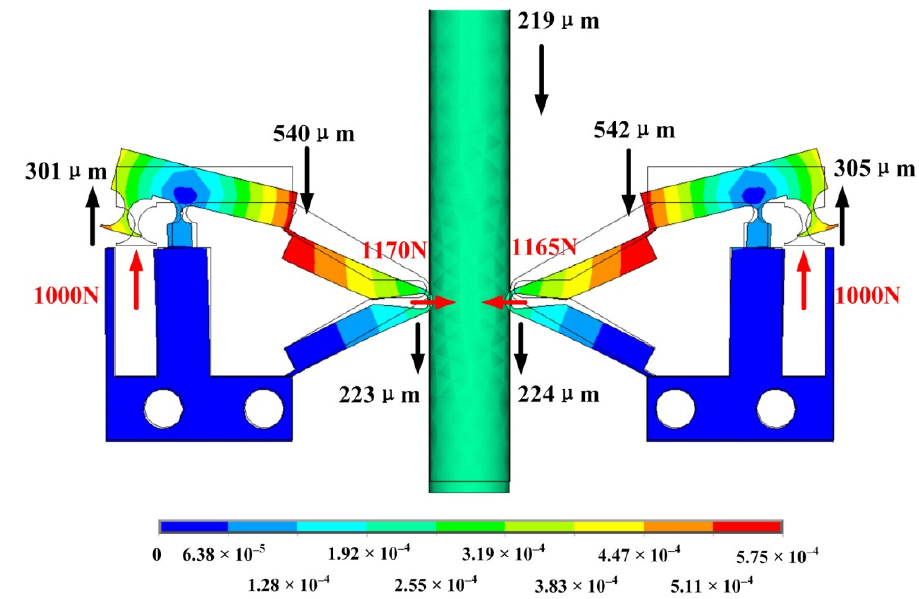
Figure 11. Deformation of the Amplification structure.